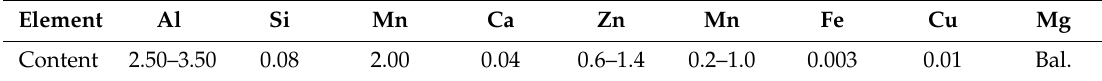
Table 3. Chemical composition of AZ31B magnesium alloy (wt.%).